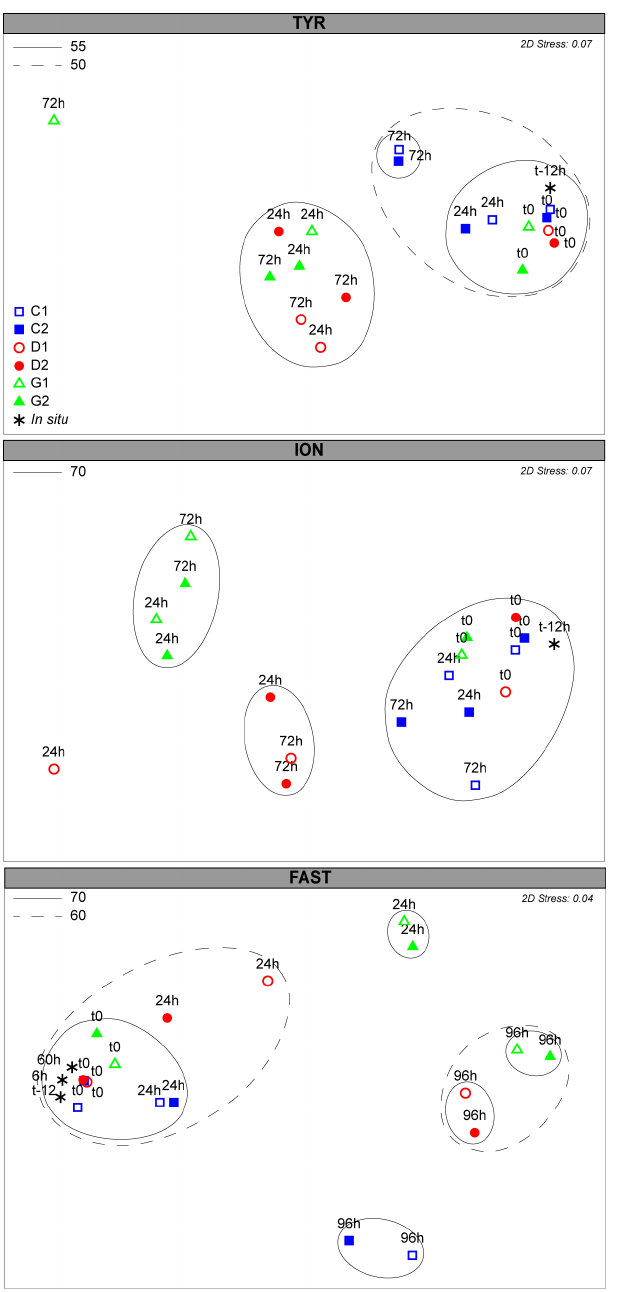
Figure 5. Non-metric dimensional scaling (NMDS) plot of bacterial community composition over the course of the three experiments based on Bray–Curtis dissimilarities of 16S rDNA sequences. Sam- ples clustering at different levels of similarity are circled together. All circles represent clusters which are significantly different from each other ( p< 0 . 05) based on a PERMANOVA test.